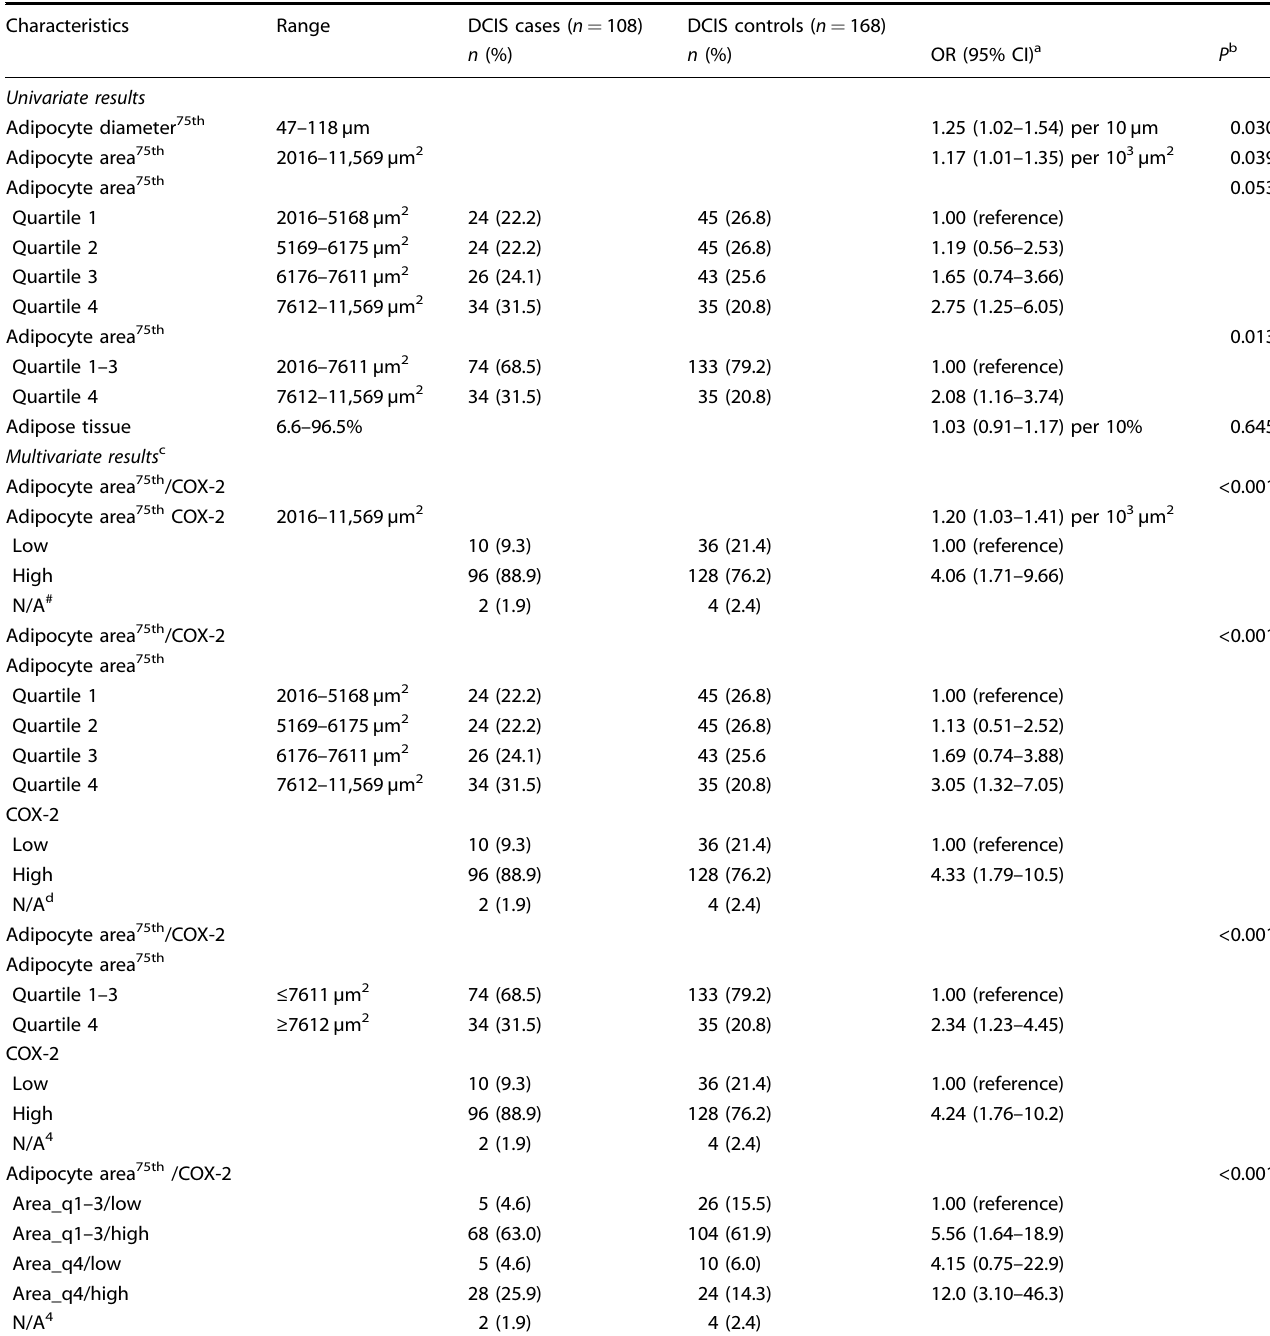
Table 3. Univariate and multivariate results of adipocyte characteristics and COX-2 expression in relation to subsequent iIBC.